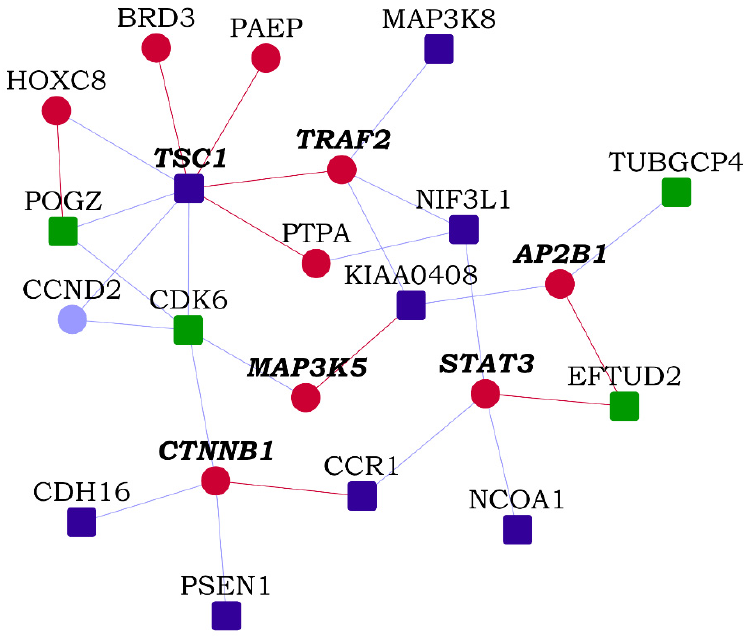
Figure 9. A partial network view of novel protein–protein interactions (PPIs) interconnecting hypoplastic left heart syndrome (HLHS) genes with microcephaly-associated genes: Genes are shown as nodes and PPIs as edges. As the integrated HLHS and microcephaly interactome is very large, only a partial view incorporating genes that are involved in neuronal death processes and the novel interactors of HLHS-associated genes/microcephaly-associated genes are shown. Legend—square-shaped dark blue nodes: HLHS-associated genes; square-shaped green nodes: microcephaly-associated genes; nodes with bold and italicized labels: genes involved in neuron death; red nodes/edges: novel interactors/interactions; light blue nodes/edges: known